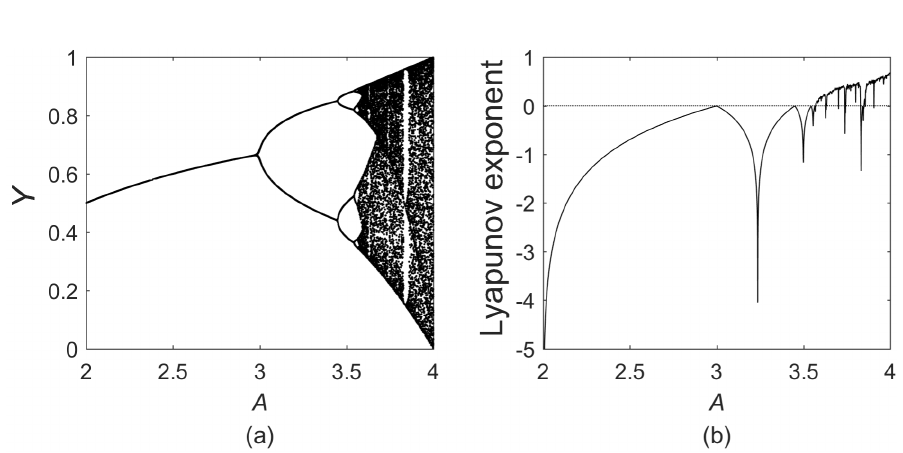
gives a probability distribution function